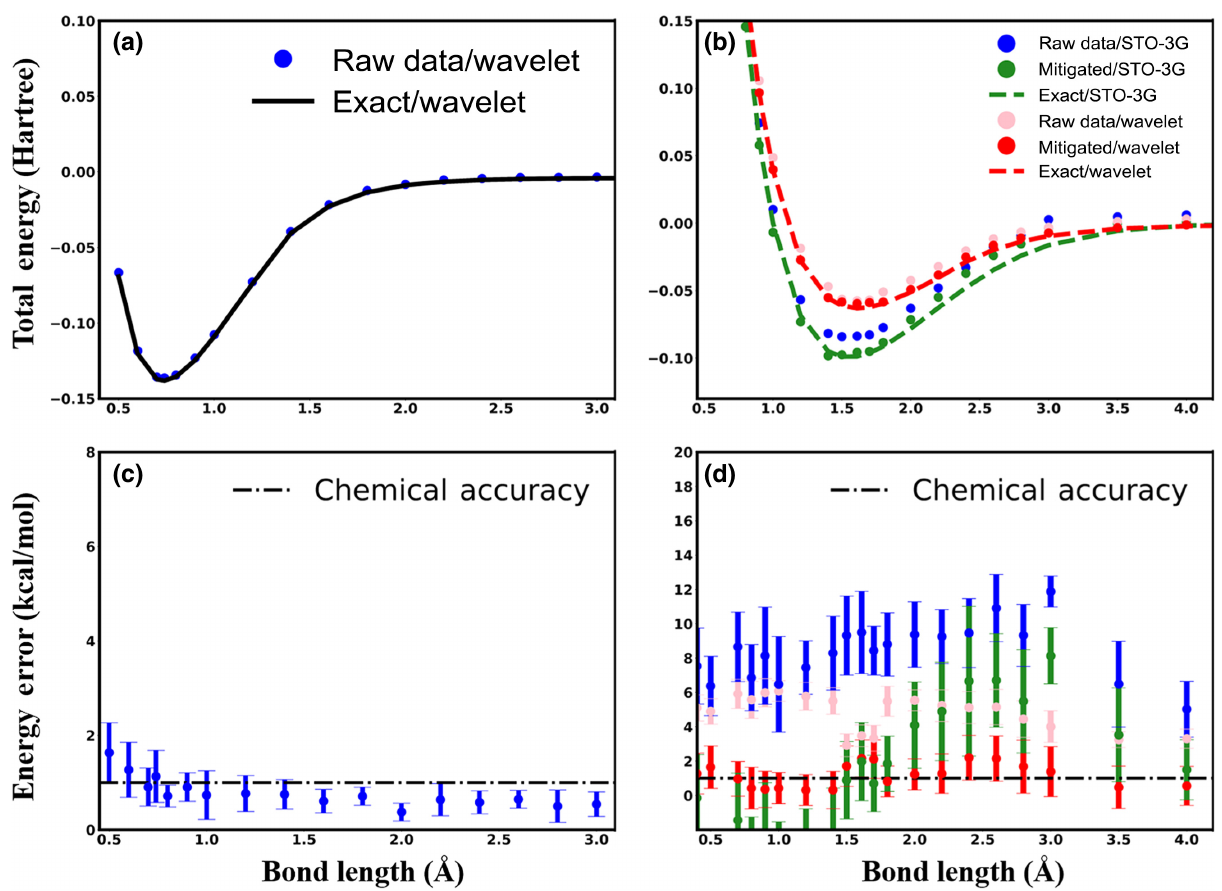
FIG. 5. Potential energy curves and computational errors of H 2 and LiH obtained from calculations under noisy environments. The errors presented for the Daubechies wavelet and the STO-3G methods are deviations from their respective classical exact FCI calculation values. (a) H 2 . Results calculated using the minimal basis Daubechies wavelet molecular orbitals (blue dots) as well as the classical FCI (solid line) are shown. (b) LiH. The blue (pink) dots depict the raw data calculated from the STO-3G (DW) basis set. The green (red) dots denote the extrapolated energies over three different CNOT gate counts from the STO-3G (DW) basis set. These simulations with noise are averaged over ten sets of VQE experiments with 10 4 shots for each iteration. The solid lines are the respective classical FCI results. (c) H 2 errors. The color scheme is the same as in the legend of (a). (d) LiH errors. The color scheme is the same as in the legend of (b). The error bars represent the 95% confidence uncertainties that take the standard error of experiments at each CNOT gate count and the residues of linear regression into account. Most of the errors after mitigation are within the chemical accuracy defined as 1